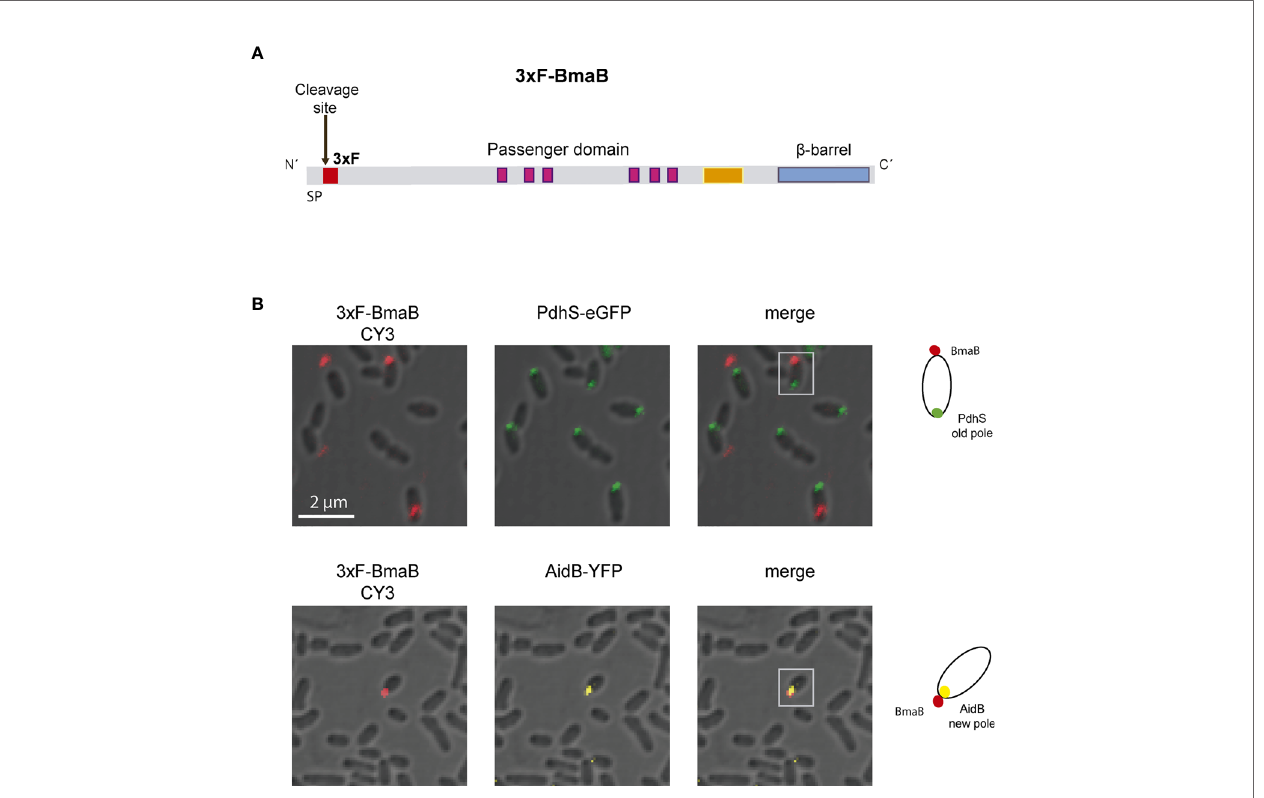
FIGURE 5 | Polar localization of BmaB. (A) Schematic representation of the 3xFLAG tag in the BmaB protein. The FLAG (in red) was cloned immediately after the predicted cleavage site of the signal peptide. (B) Immuno fl uorescence assays with anti-FLAG antibodies were performed in B. suis -3xFLAG-BmaB expressing the pole markers PdhS-eGFP (upper panel) and AidB-YFP (lower panel). Bacterial shapes were observed by Differential Interference Contrast (DIC) images and cells were observed by confocal microscopy using a ZEISS LSM 880 Confocal Laser Scanning Microscope. In the fi rst panel (from left to right) the label corresponding to BmaB is observed, in the second panel the label corresponding to the pole marker (PdhS or AidB) and in the third panel the merge of the previous ones. Gray squares indicate which bacteria are represented in the cell cartoons on the right that indicate the localization of BmaB and pole markers; red dots represent 3xFLAG- BmaB green and yellow intracellular dots represent PdhS and AidB localization (old and new pole respectively). The cartoons are based on the observations of this experiment and previous data on the localization of the pole markers AidB-YFP and PdhS-eGFP (Dotreppe et al., 2011; Van der Henst et al., 2012) and BmaB subcellular fractioning analysis (Bialer et al.,